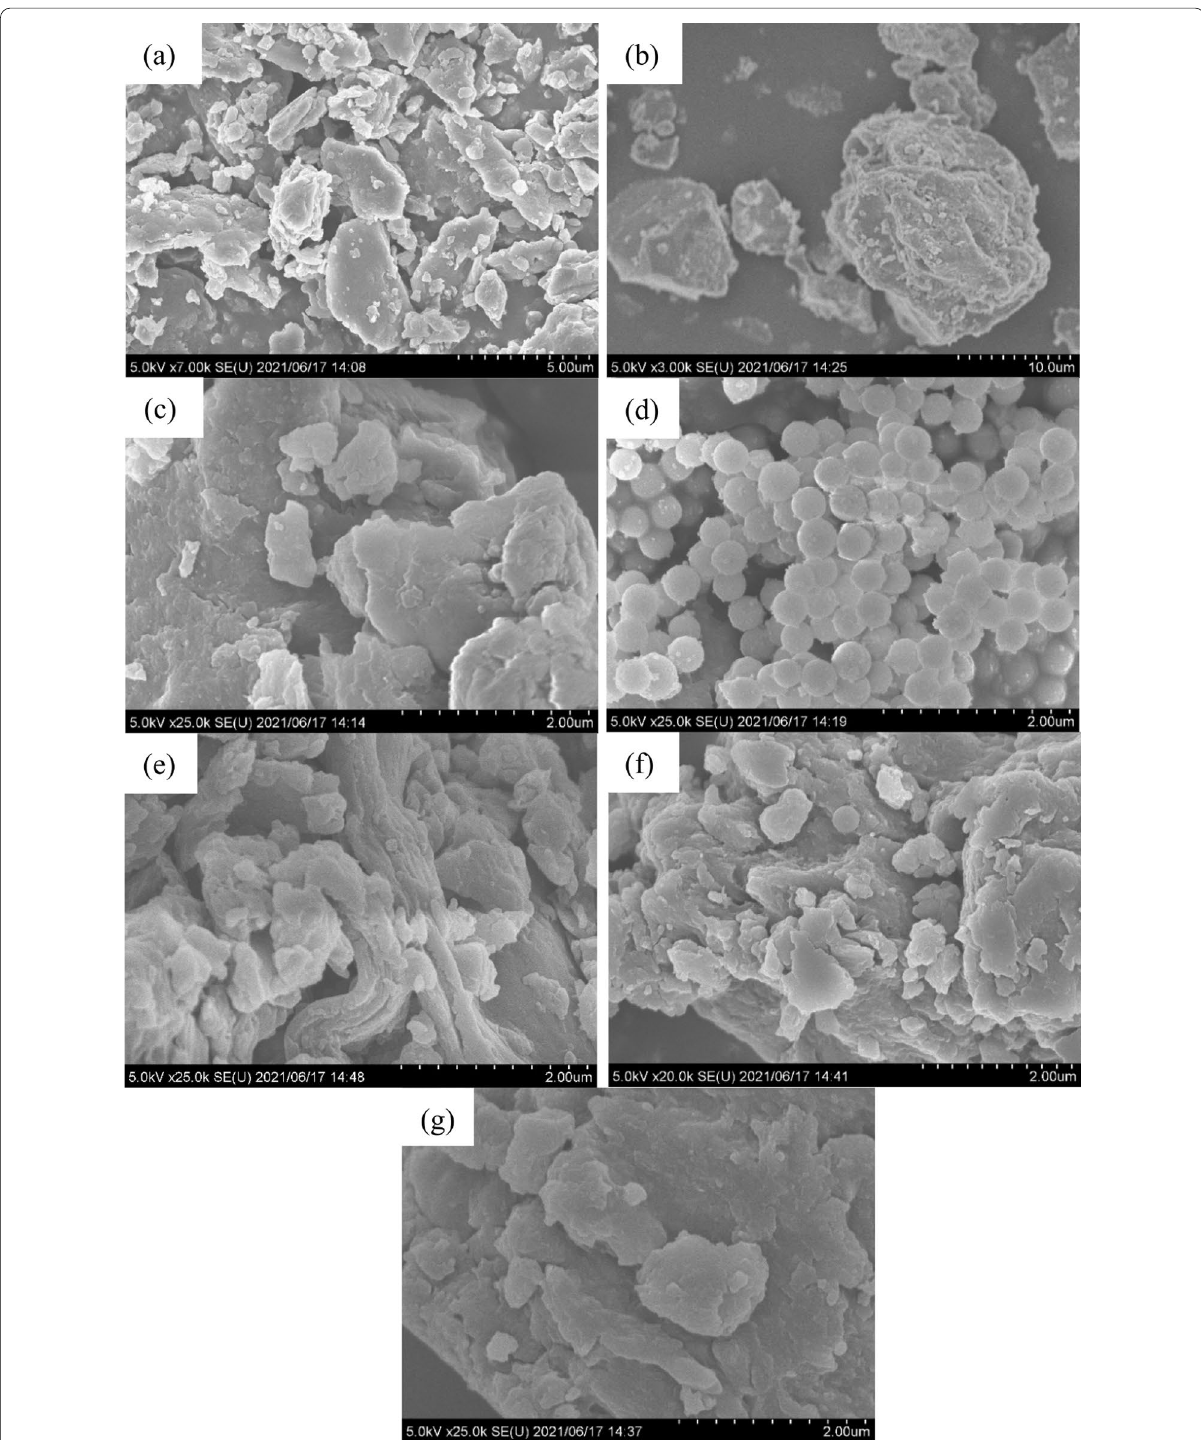
Fig. 1 SEM images of as-prepared materials: ( a ) ball-milled single raw biomass cherry tree leaves (BM); ( b ) humic acid; ( c ) ball-milled raw biomass cherry tree leaves and humic acid (HBM); ( d ) carbonization of BM at 400 °C (BM-400); ( e ) carbonization of HBM at 400 °C (HBM-400); ( f ) carbonization of HBM at 300 °C (HBM-300) and ( g ) carbonization of HBM at 200 °C